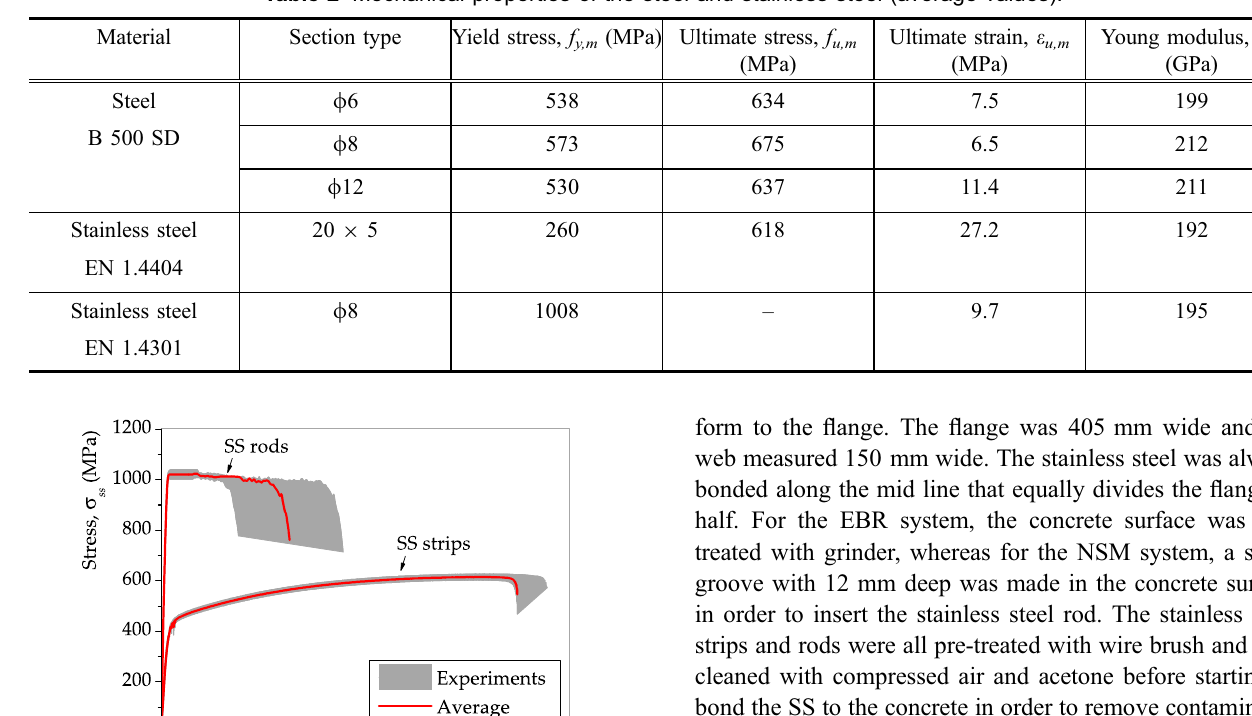
Table 2 Mechanical properties of the steel and stainless steel (average values).